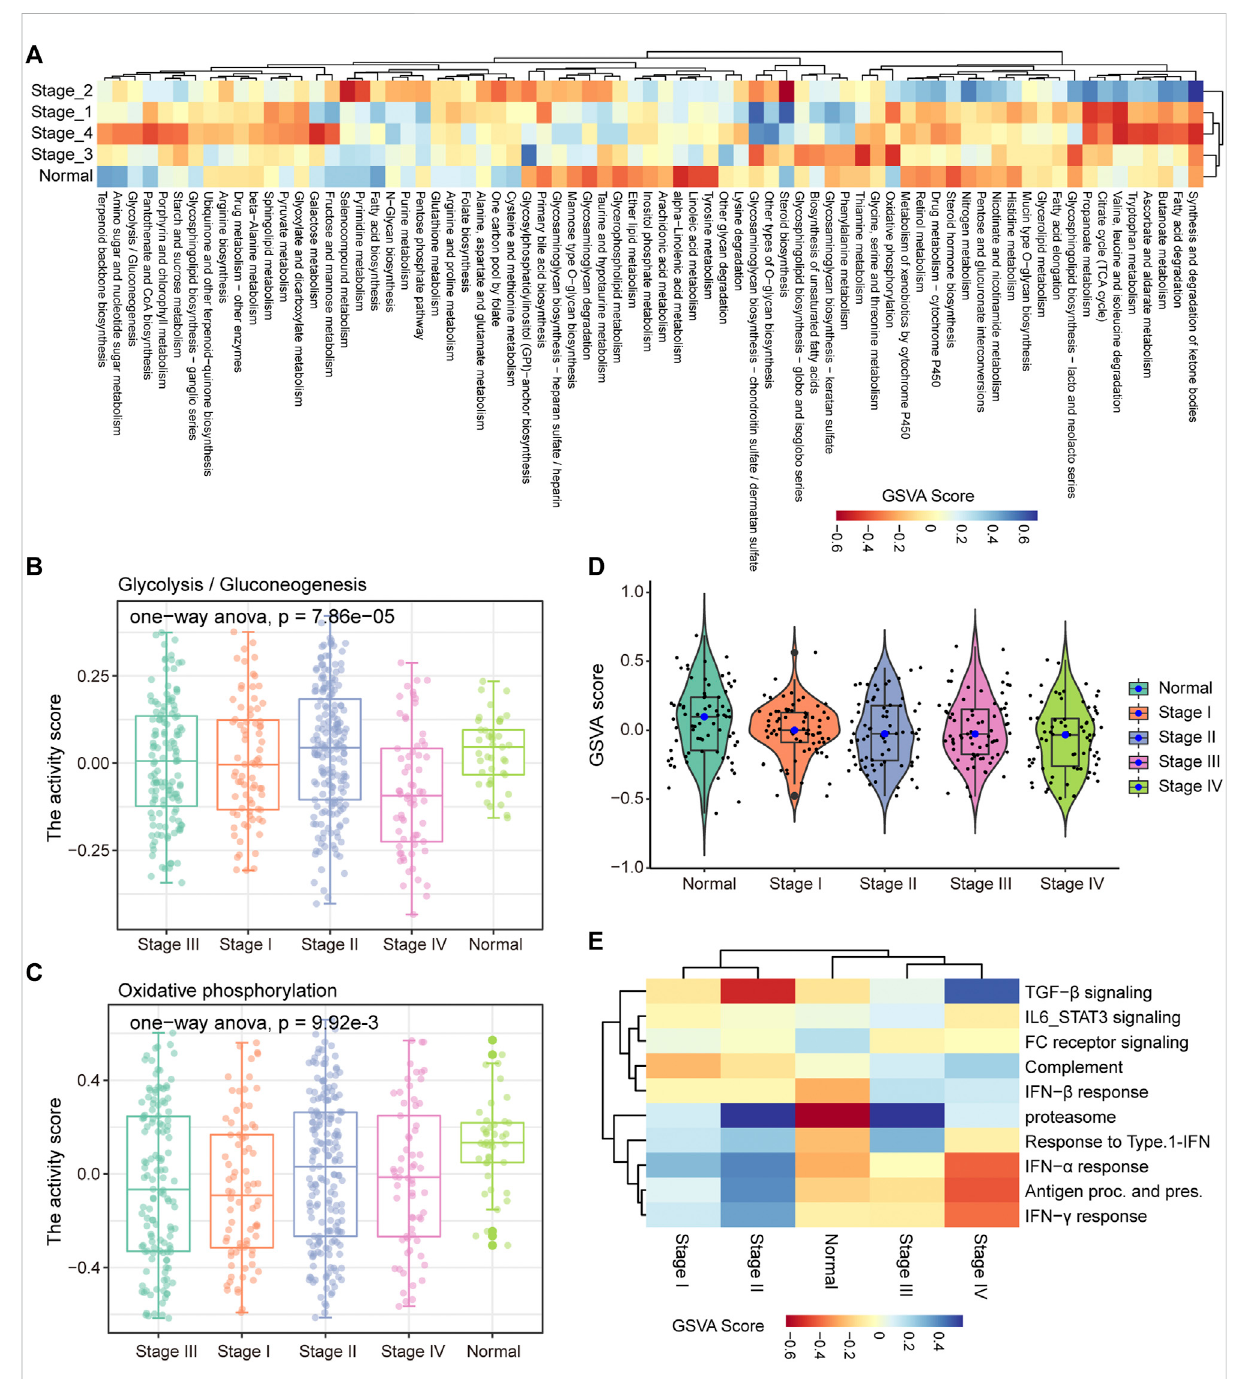
FIGURE 2 Stage-speci fi c metabolic and immune activity. (A) The enrichment scores of the 85 metabolic pathways calculated by GSVA in the fi ve categories (stage I, stage II, stage III, stage IV, normal samples) are displayed by the heat map. (B – C) Boxplot shows the glycolysis and OXPHOS pathway scores of each sample in the fi ve categories. ANOVA is used to assess statistical differences between groups. (D) The distribution of enrichment scores for 85 metabolic pathways in the fi ve categories is shown by violin chart. (E) The heat map shows the enrichment scores of each immune-related pathway in the fi ve